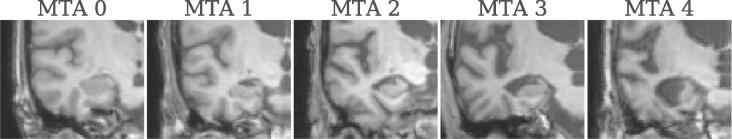
Example of the Scheltens’ MTA scale, with progressive atrophy of the hippocampus, the choroid fissure and the inferior lateral ventricle. The image selected for each score was given the same rating by both radiologists in this study. Each hemisphere is rated individually.